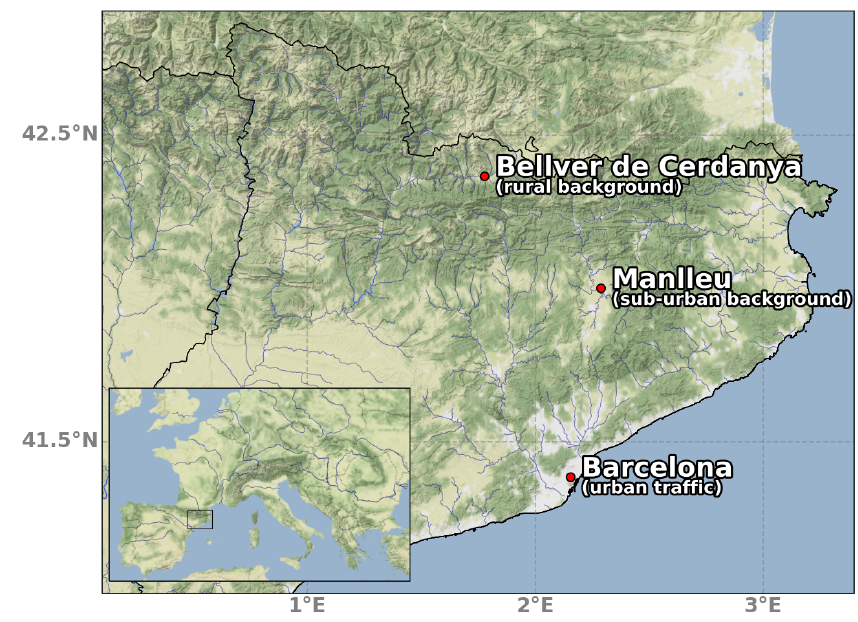
Figure 1. Geographical location of the XVPCA stations in Catalonia